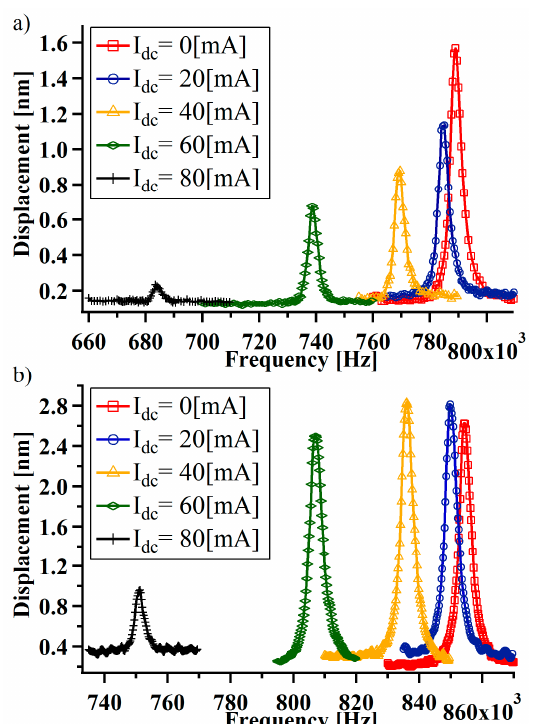
Figure 4. Displacement vs. frequency for applied I dc current for ( a ) stress-free case; and ( b ) an applied stress of 76